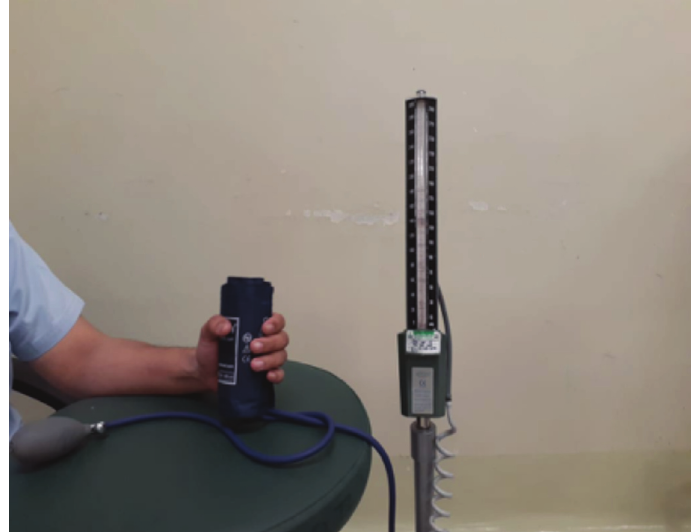
Fig. 1: Demonstrating hand grip strength using sphygmomanometer.